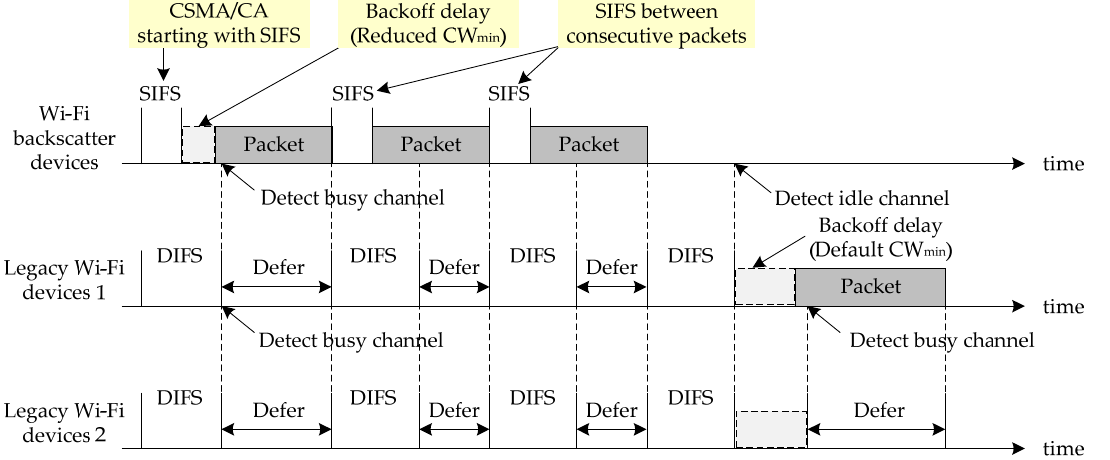
Figure 3. Example of burst transmission of DCO.